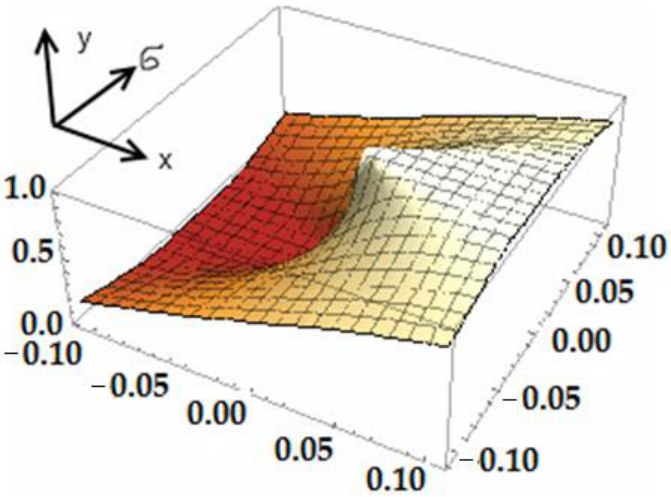
Figure 11. Distribution of the random value of deviations y = θ ( u ), where x = u = (x i − ξ )/( ξ · σ ), with center ξ and dispersion σ 2 .